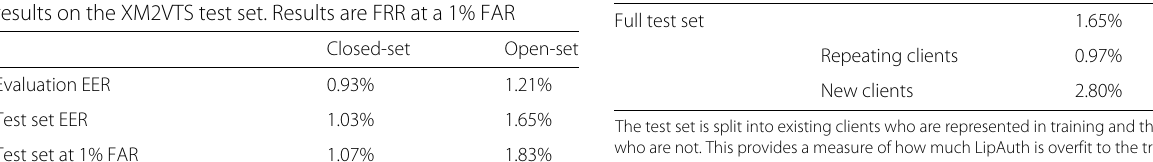
New open-set protocol